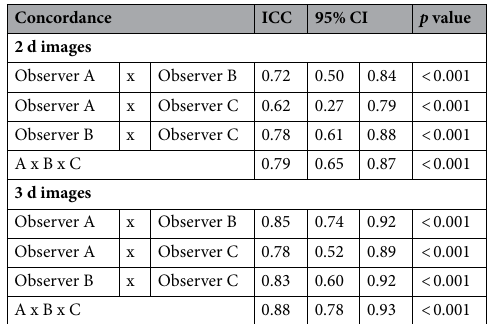
Table 3. Intraclass Correlation Coefficient for internal consistency and the descriptive level ( p -value) of skin improvement among the observers and the 3D SPM (total sample n = 48). Two-way Model; 95% CI (confidence interval); x =